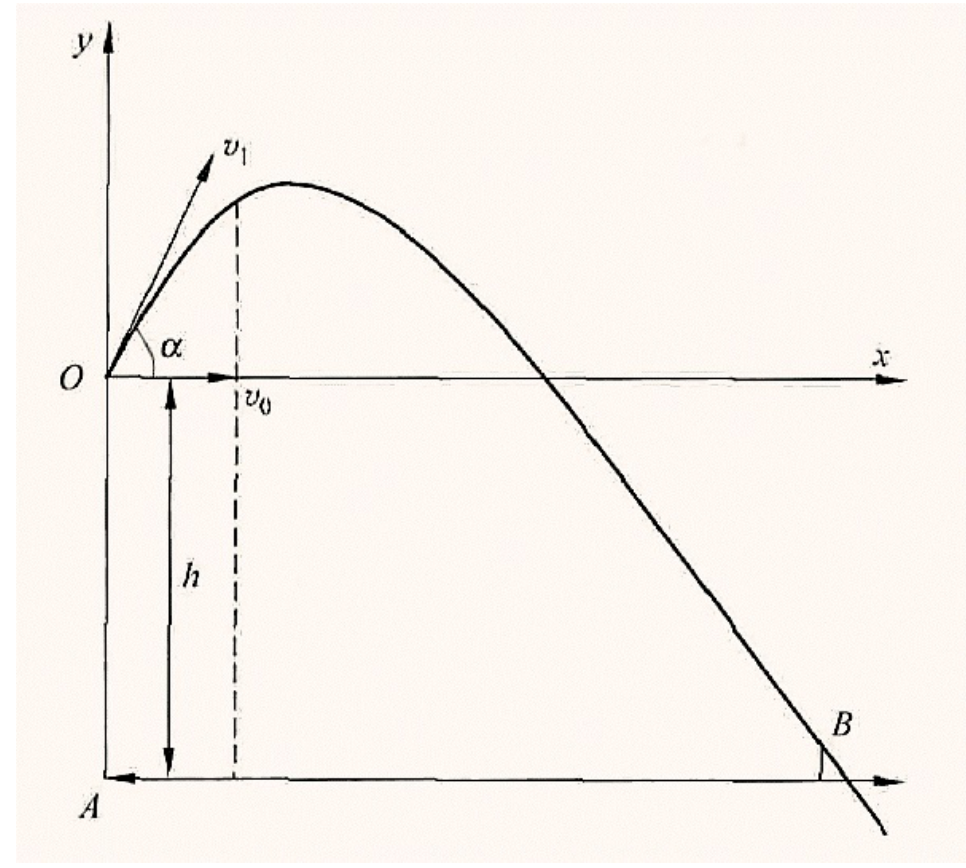
Fig. 3 The coordinates of the shot motion when considering air